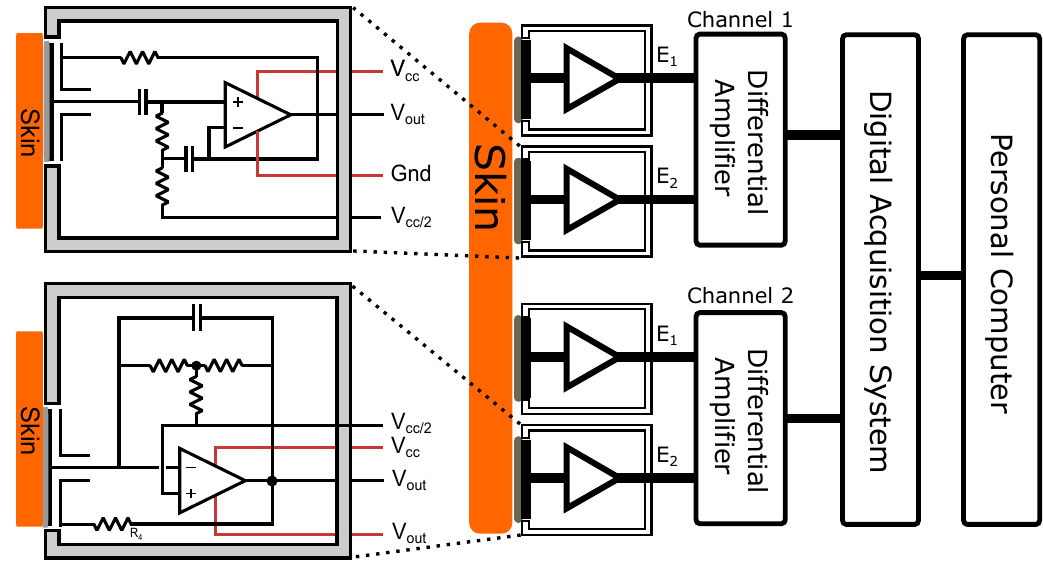
Figure 4. System